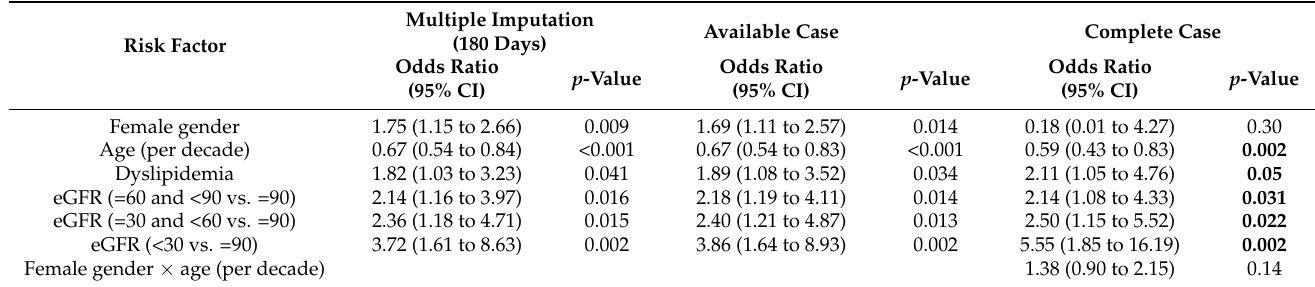
Table 4. Odds ratio to receive CD-TLR for all risk factors in the three sensitivity